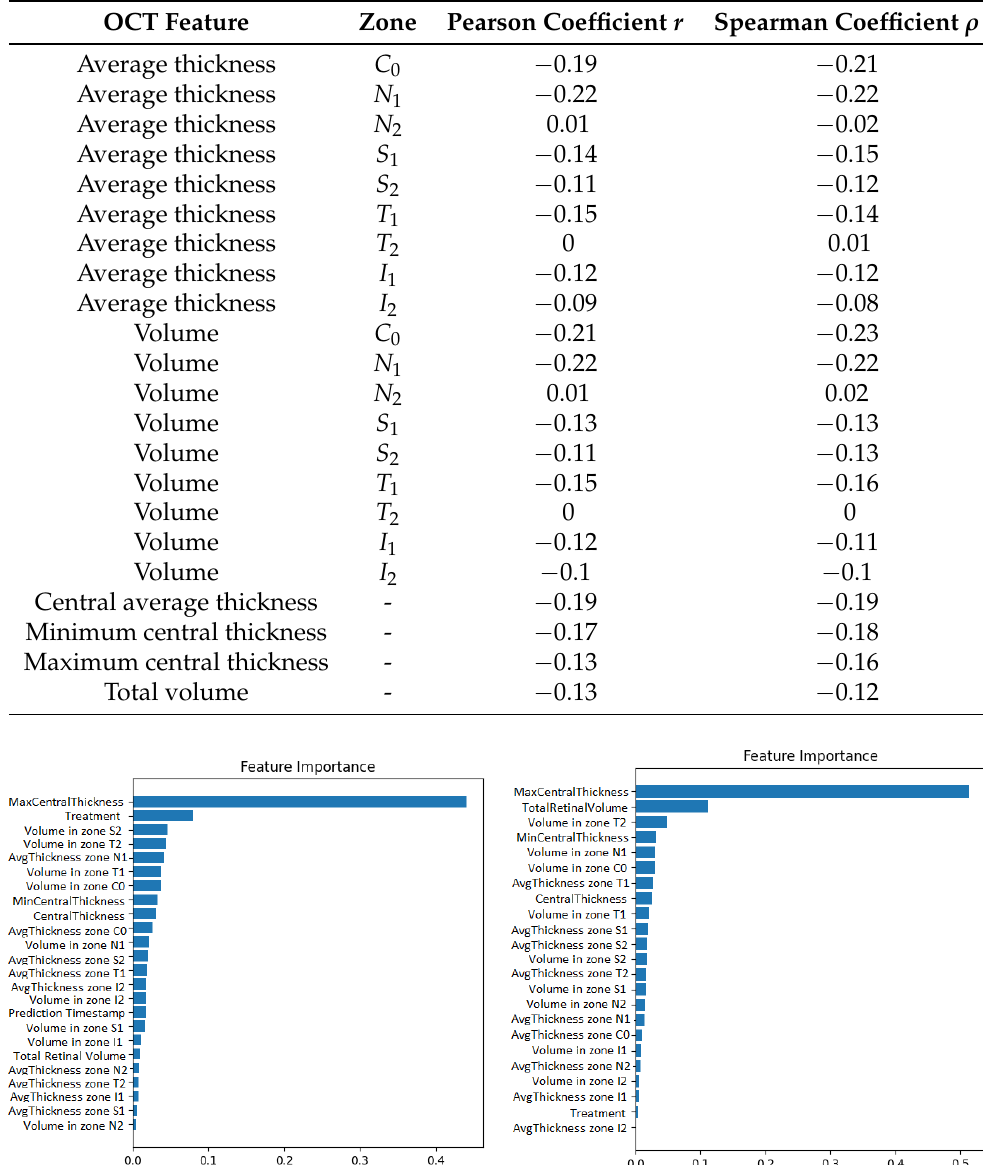
Figure 5. Gradient boosting machine showing how much the numerical OCT features influence the prediction of visual acuity. The case with prediction timestep as a features appears on the left. The case with 1-month resampling appears on the